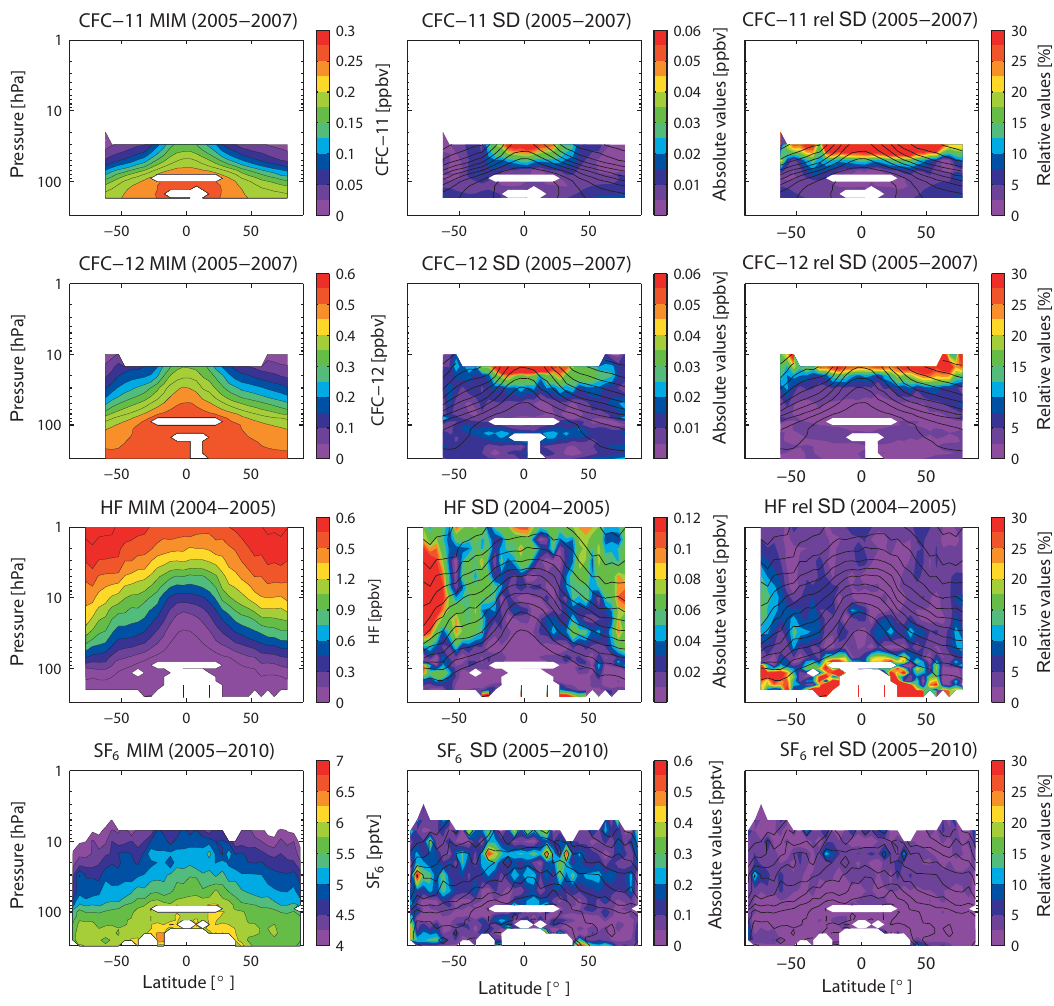
Figure 12. Summary of CFC-11, CFC-12, HF and SF 6 annual zonal mean state for the respective evaluation period. Annual zonal mean cross sections of the MIM of each trace gas are shown in the left panel. Additionally, the standard deviations (SD) over all respective instruments are presented in the middle panel. Relative standard deviations (calculated by dividing the absolute standard deviation by the MIM) are shown in the right panels. Black contour lines in the middle and right panels give the MIM distribution. Instruments included are MIPAS, ACE-FTS, and HIRDLS for CFC-11, CFC-12, HALOE and ACE-FTS for HF, and MIPAS, and ACE-FTS for SF 6 . The MIM and standard deviation are only displayed for regions where all instruments provide